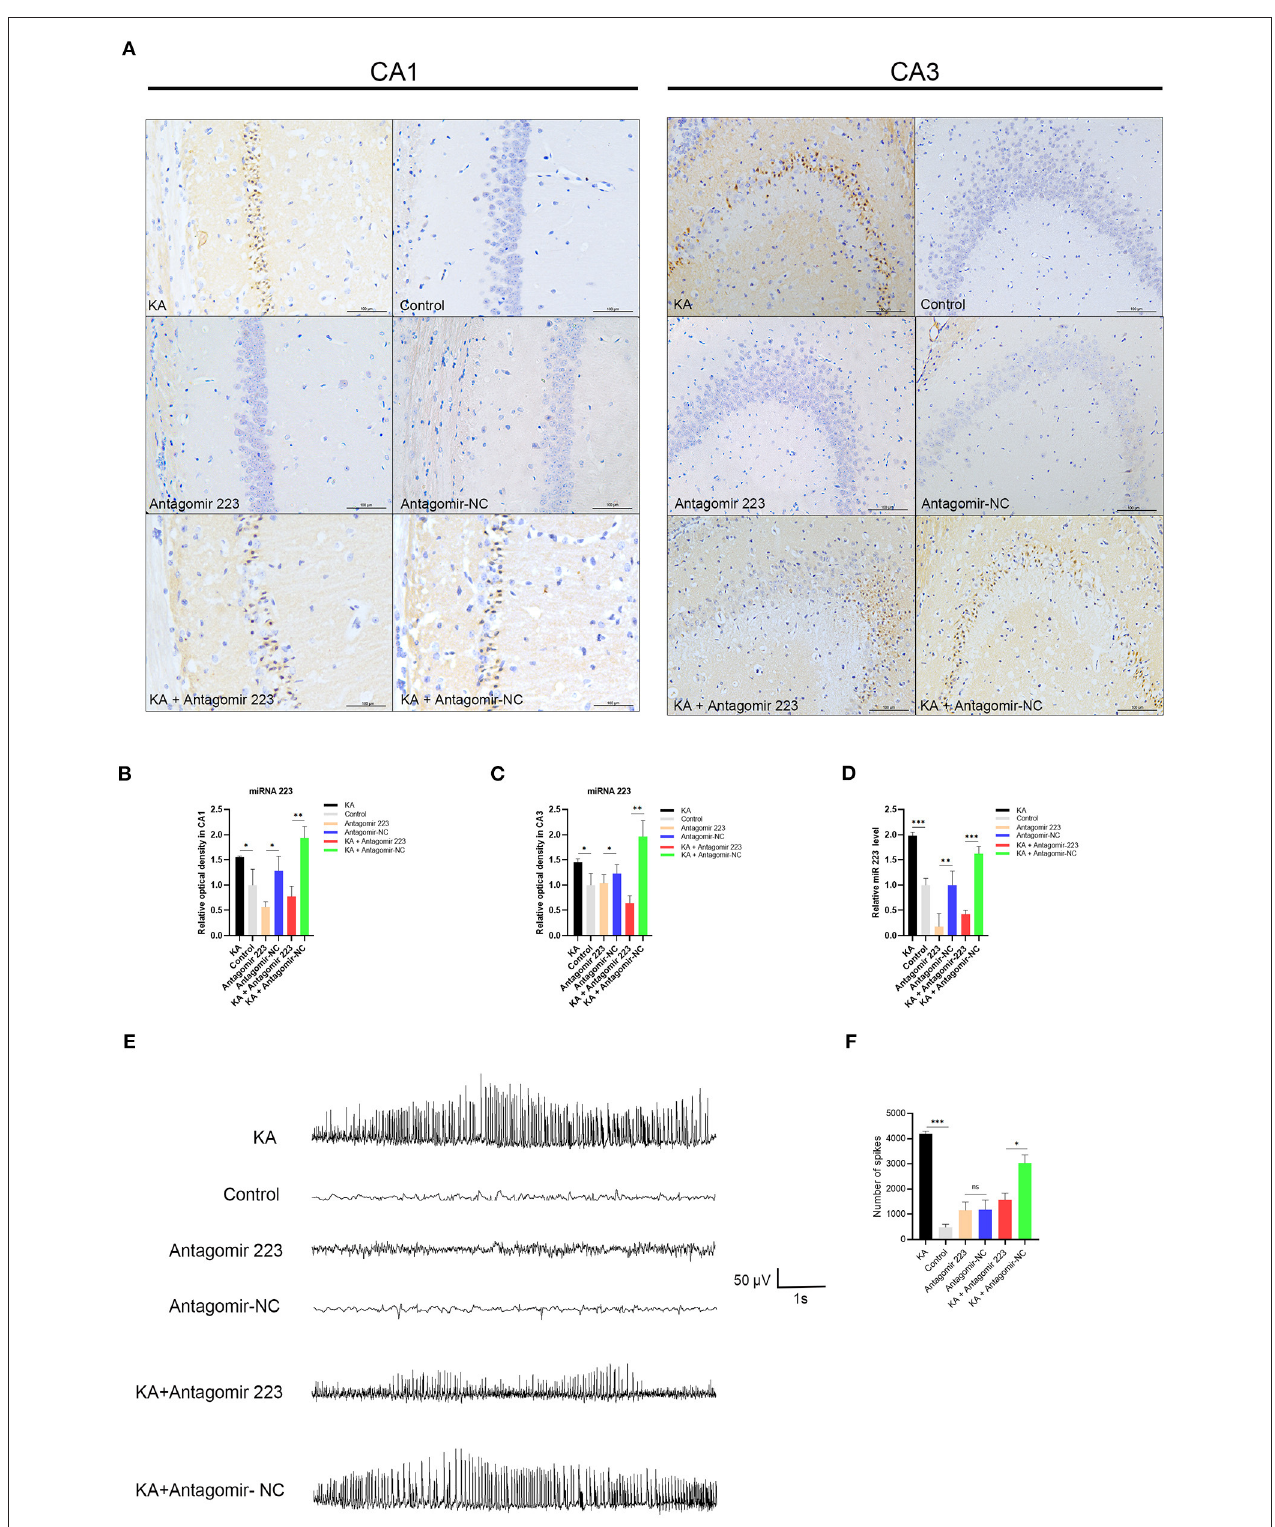
FIGURE 5 | Effects of antagomir 223 on hippocampal miR 223 levels and seizure-like EEG findings. Mice were injected intracerebroventricularly with antagomir 223 or antagomir-NC alone or at 60min after status epilepticus. (A) In situ hybridization of miR-223 in the hippocampal tissue. High expression levels of miR-223 were observed in the CA1 and CA3 regions of the KA and KA + Antagomir-NC groups, while the miR 223 hybridization signals in these regions were weaker in the